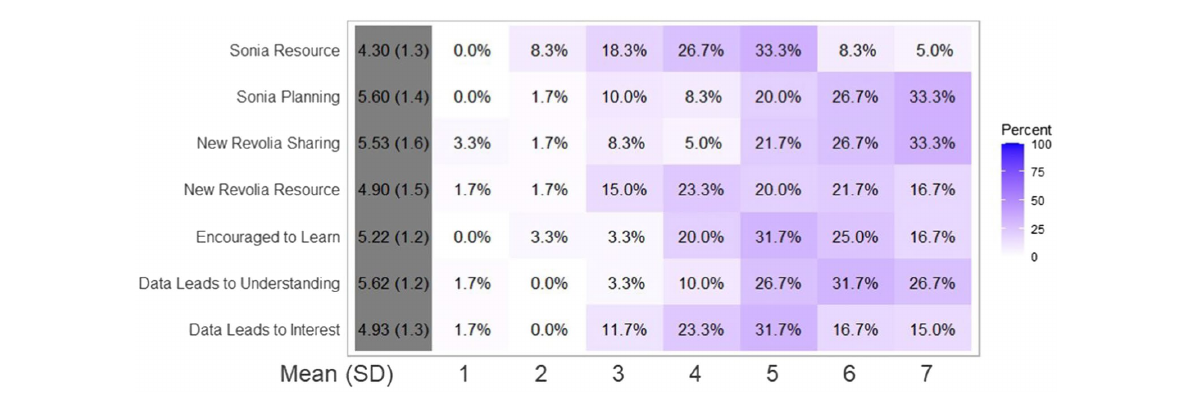
TABLE 1 Descriptive statistics for Likert scores for each survey question as asked in Figure 6 . Survey question